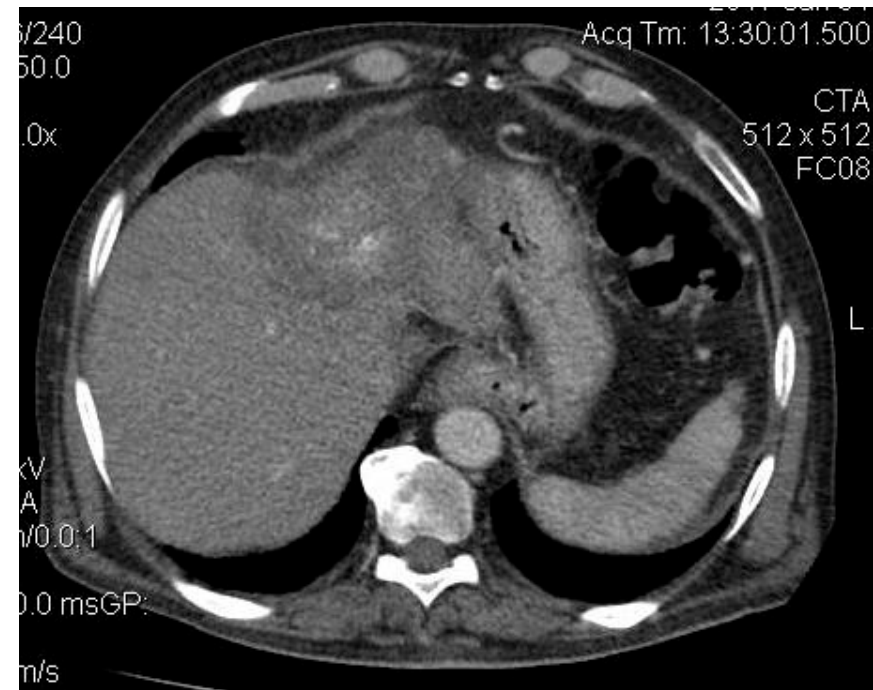
Figure 5. Lesion response to the embolization—tumour is calcified and shrunk.